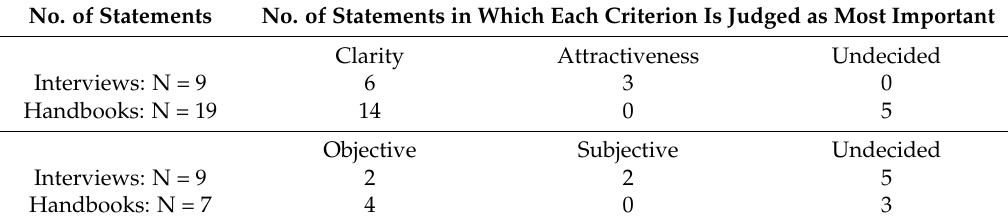
Table 1. Number of statements in which each criterion is judged as most